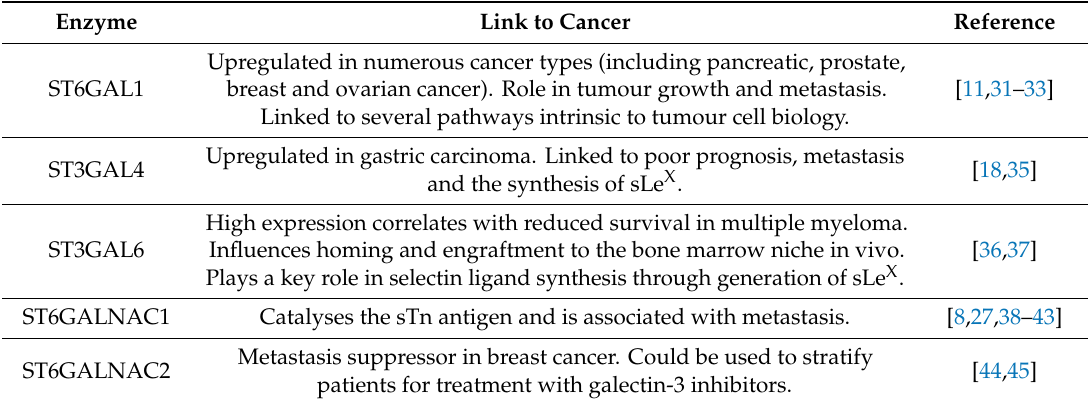
Table 1. Key examples of sialyltransferases important in